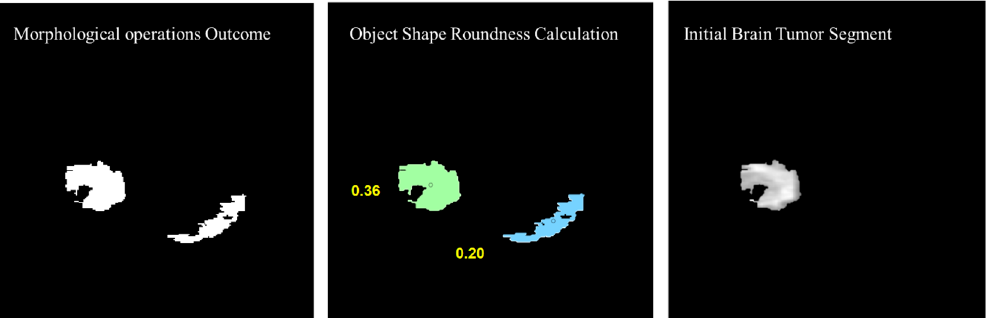
Figure 13. Object shape roundness calculation and generating the initial tumor segment.